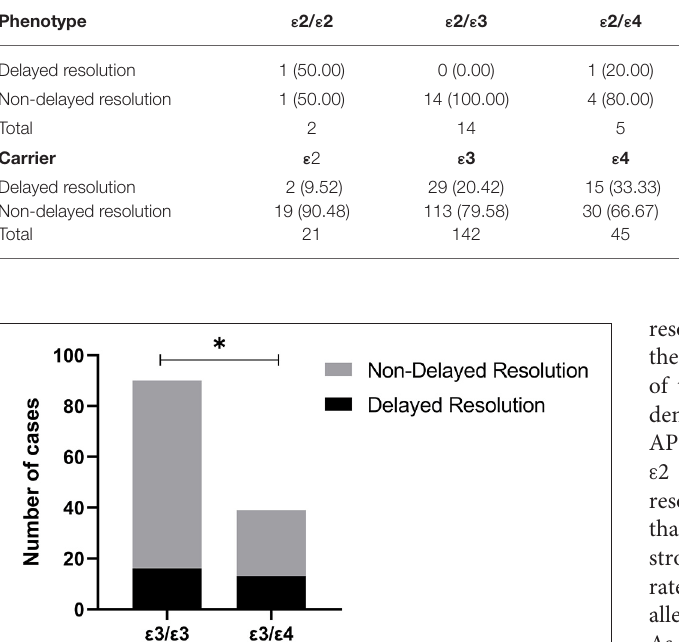
TABLE 5 | Analysis table of delayed resolution rate in the different APOE genotypes and allele carriers (n, %) .